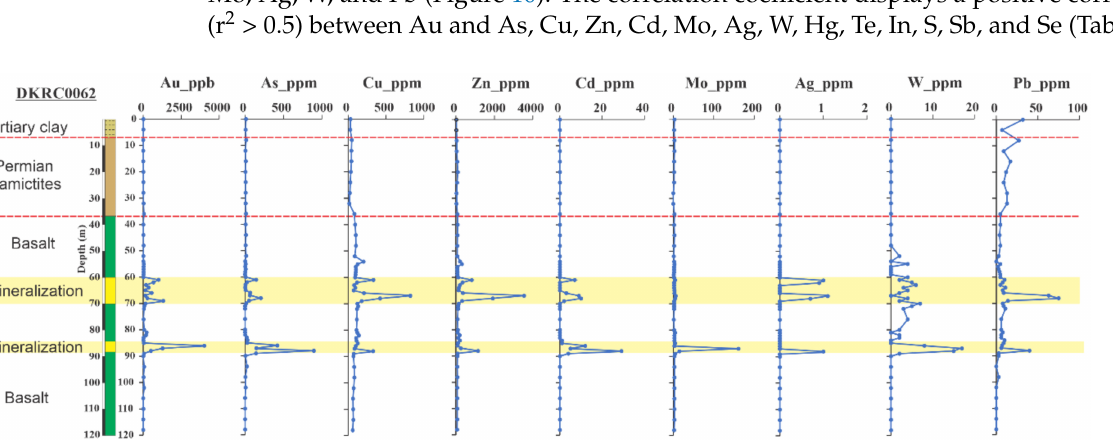
Figure 10. Vertical chemical variations from the bedrock to the surface in drill hole DKRC0062 showing that the mineraliza- tion coincides with elevated levels of Au, As, Cu, Zn, Cd, Mo, Ag, W, and